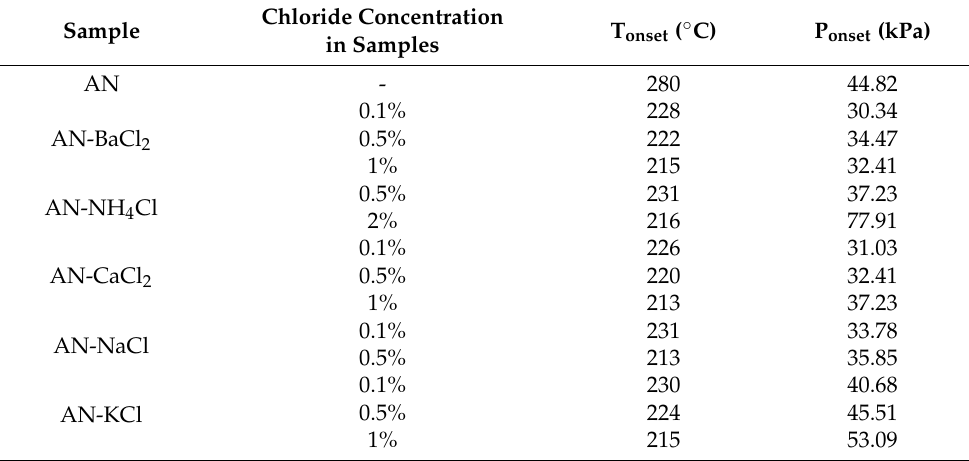
Table 7. Effect of chloride on AN parameters studied by MCPVT. Reprinted with the permission of Elsevier from